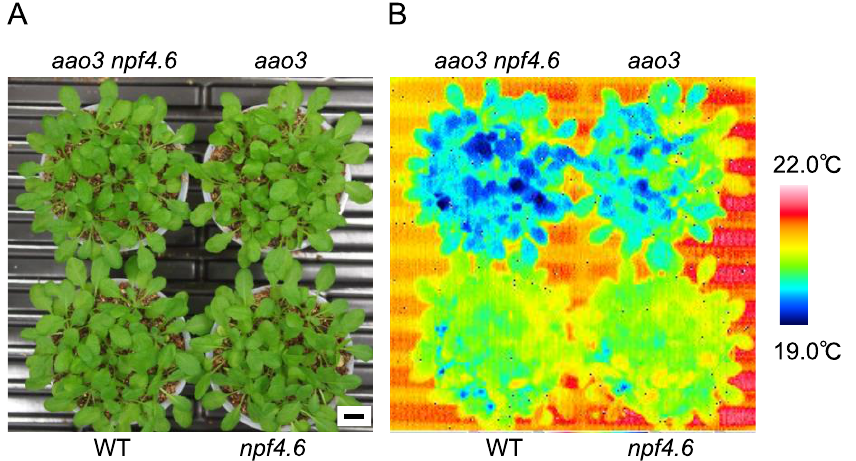
Figure 1. NPF4.6 is a positive regulator of stomatal closure. ( A ) Wild type (WT), npf4.6-1 ( npf4.6 ), aao3-4 ( aao3 ) and aao3-4 npf4.6-1 ( aao3 npf4.6 ) plants (approximately 1-month-old) grown under a day and night cycle (10 h light/14 h dark). Scale bar = 1 cm. ( B ) Leaf surface temperature of plants in ( A ) observed by a thermal imaging camera.